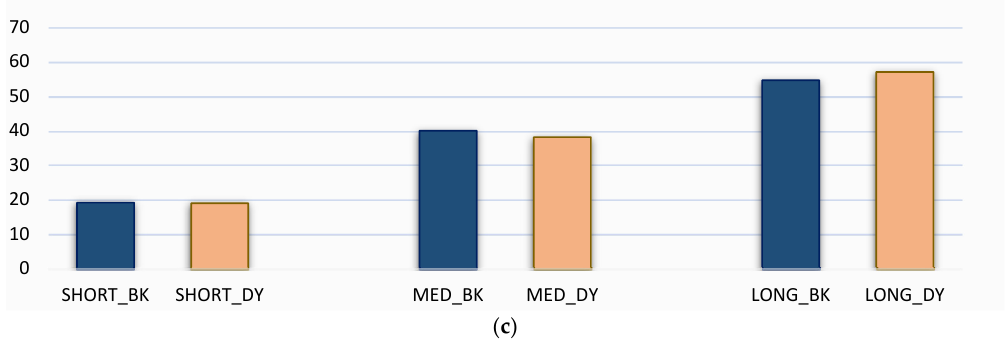
Figure 6. Side-by-side comparison of volatility spillover based on the BK18 and wavelet-based DY12 methods: ( a ) Volatility To; ( b ) Volatility From; ( c ) Total Volatility. The y-axis denotes volatility spillovers. The x-axis description is as follows: Short_BK, Med_BK, and Long_BK are within spillover indexes calculated using the BK18 method for the short-, medium-, and long-term. Short_WAV, Med_WAV, and Long_WAV are spillover indexes calculated using the DY12 method from wavelet-based series for the short-, medium-, and long-term. Total volatility is the total volatility spillover between the two mentioned methods.